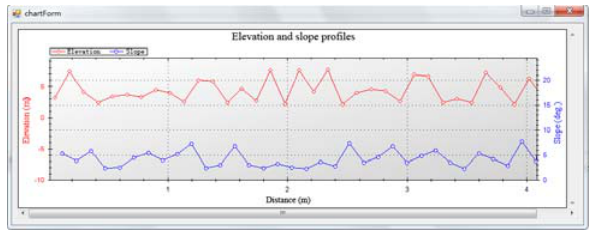
Figure 7. Elevation and slope profiles measured from the panorama